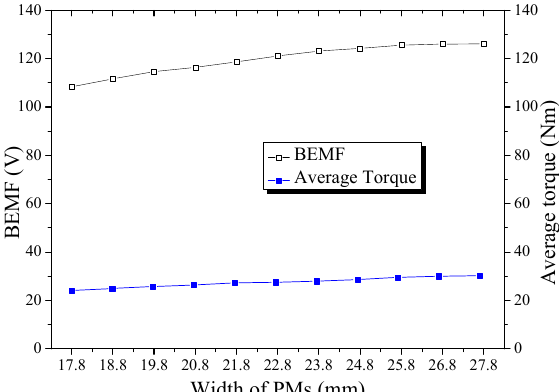
Figure 21. Variation of the BEMF and average torque versus width of